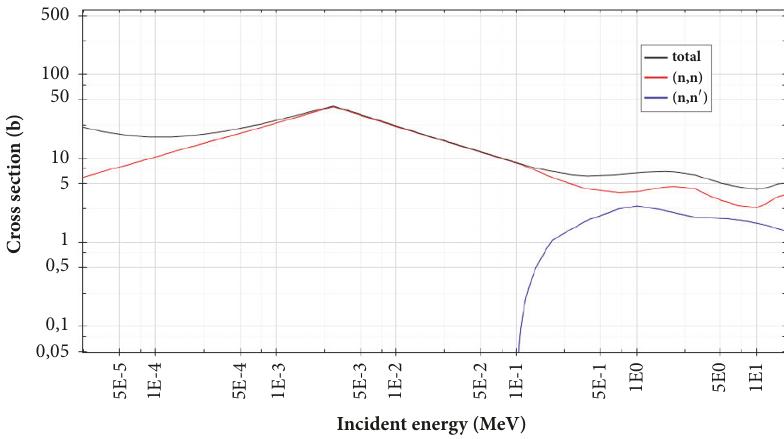
Figure 18: Total, elastic, and inelastic microscopic cross section of 160